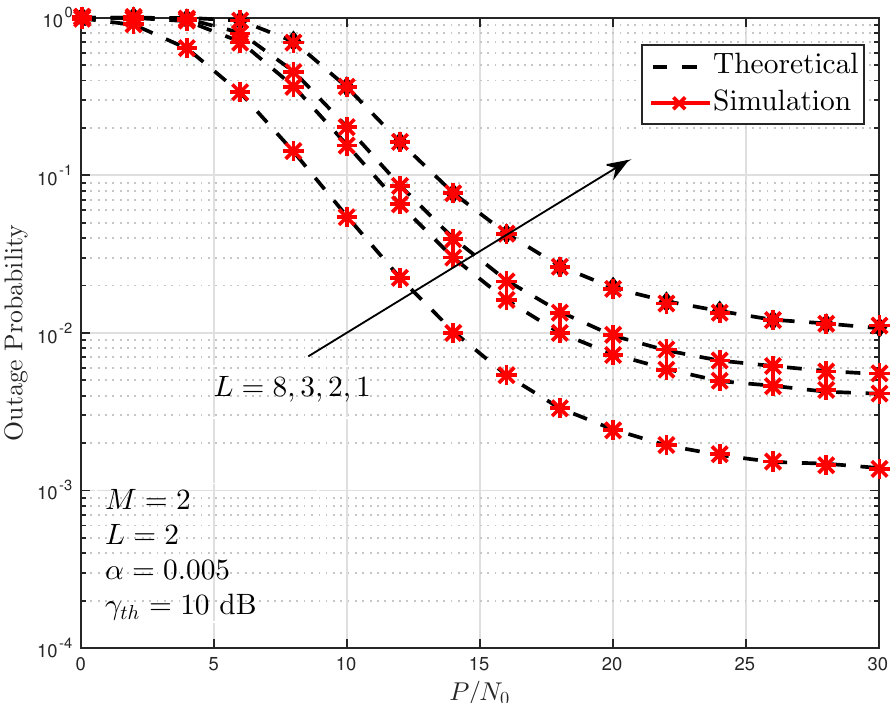
Figure 3. Outage probability of the secondary network versus P / N 0 for different numbers of hops, when α =